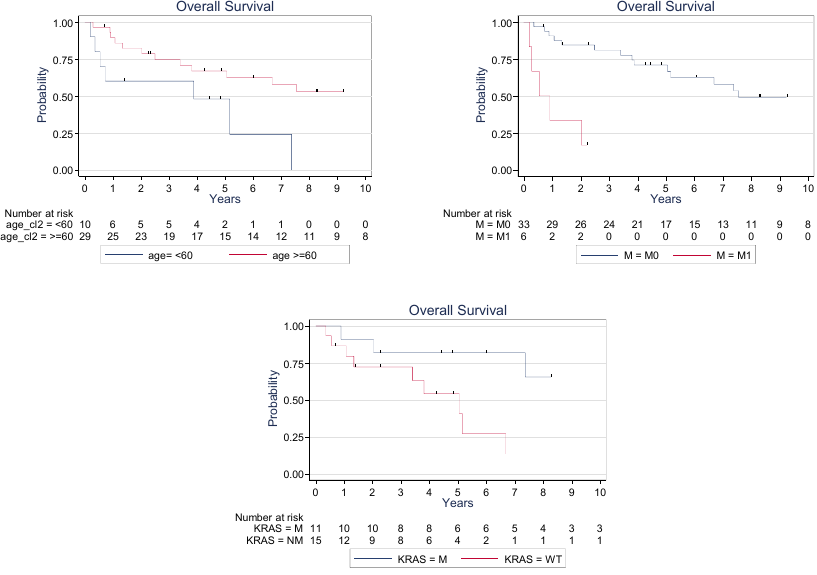
Figure 1. Kaplan–Meier plots of survival according to age, metastasis, and KRAS